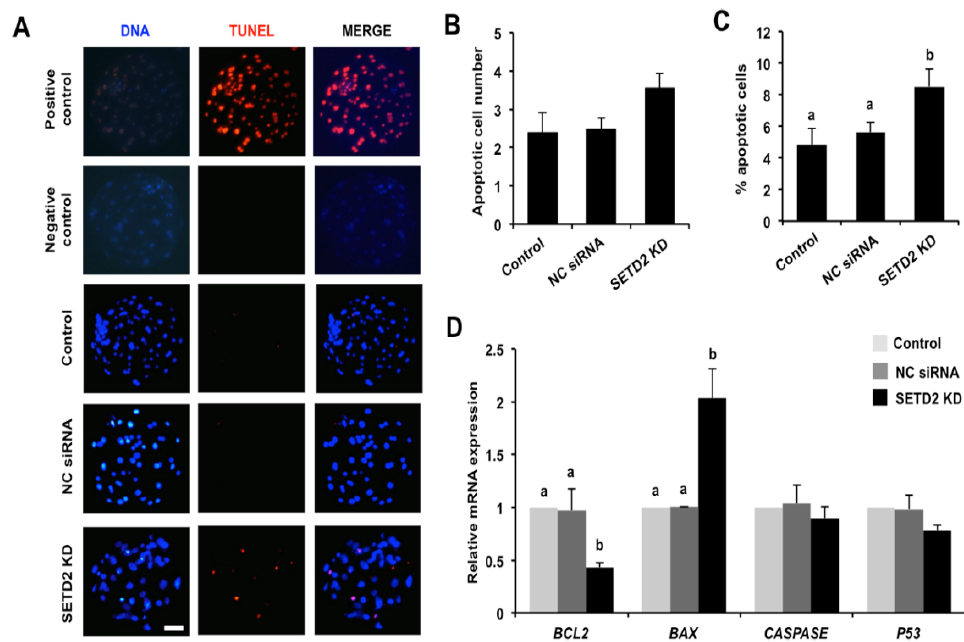
Figure 6. Effects of SETD2 KD on apoptotic ratio and the expression of pro-apoptotic and anti-apoptotic genes. ( A ) TUNEL staining of blastocysts at day 7. Red spots indicate apoptotic cells, blue spots mark nuclei. Blastocysts treated with DNase I and enzyme solution without the treatment of label solution served as the positive control group. Blastocysts only treated with DNase I without the treatment of enzyme and label solution served as the negative control group. The independent experiment was carried out for three times and 30 embryos in each group were at least included. Representative images obtained by confocal microscopy are shown. Scale bar: 50 μm. ( B ) Analysis of apoptotic cell number in blastocysts. ( C ) Analysis of apoptotic ratio in blastocysts. ( D ) Expression of pro-apoptotic ( BAX , CASPASE , and P53 ) and anti-apoptotic ( BCL2 ) genes in blastocysts. Expression levels of the indicated transcripts were analyzed by qPCR. All data are presented as mean ± S.E.M and different letters indicate significant differences ( p < 0.05).